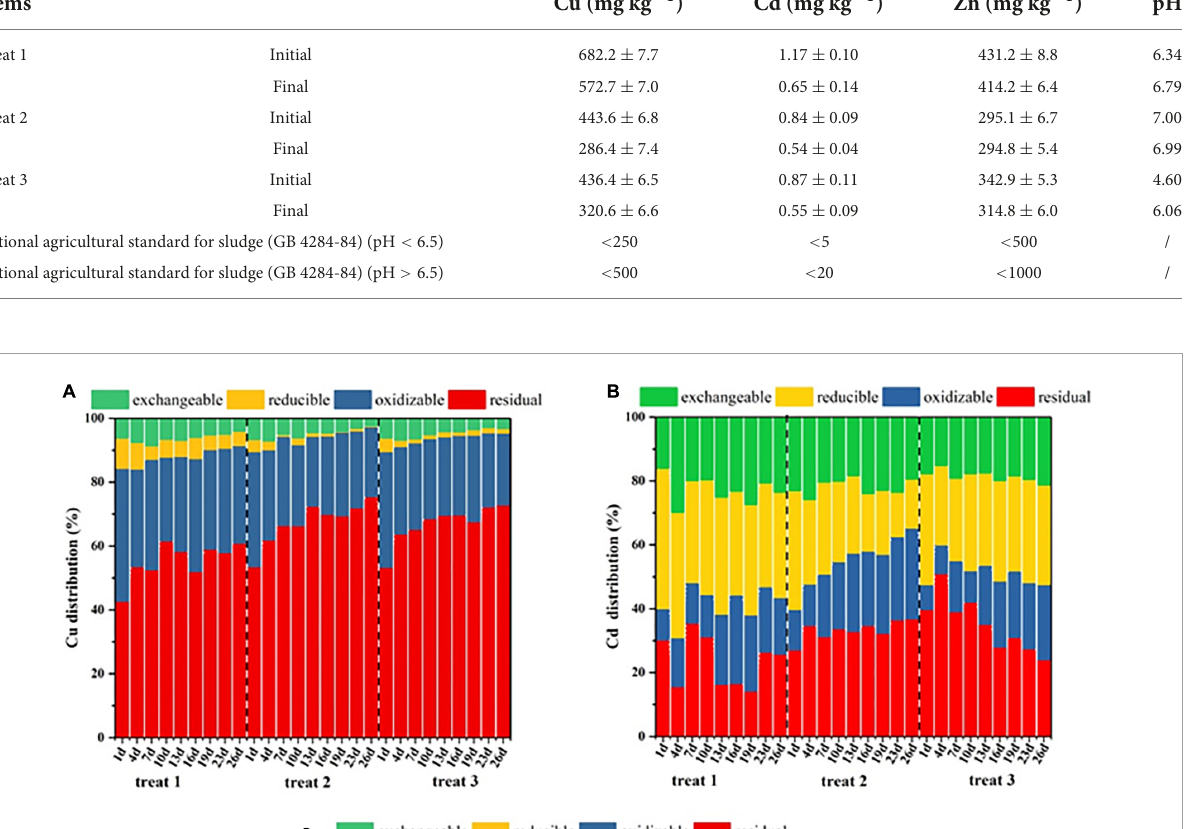
one of the reasons for the decrease in the total amount of heavy metals in each pile after composting. The contents of Cu, Cd, and Zn in treat 1 decreased by 16.05, 42.40, and 3.94%, respectively. In treat 2, the contents of Cu, Cd, and Zn decreased by 35.44, 35.71, and 0.10%, respectively. In treat 3, the contents of Cu, Cd, and Zn decreased by 26.54, 36.78, and 8.19%, respectively. It might be observed that most of the Cu and Cd contents in treat 2 and treat 3 decreased, which